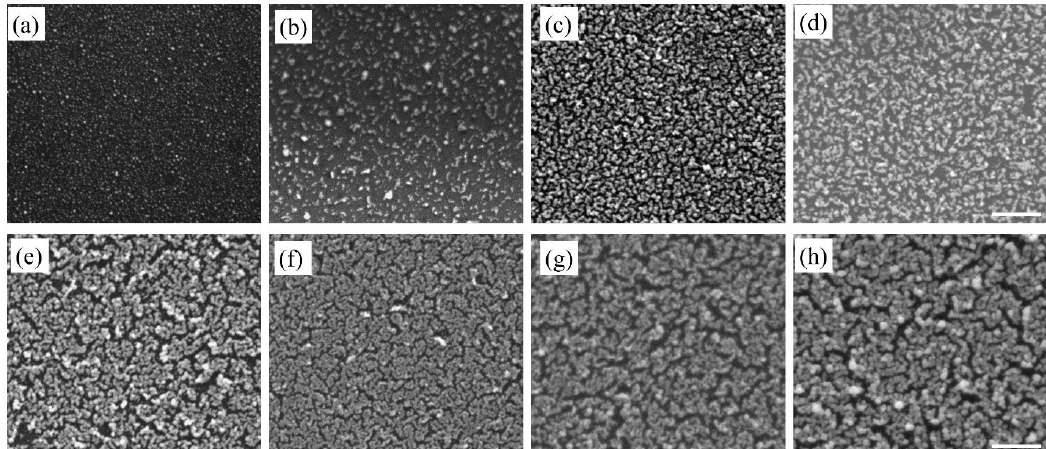
Figure 2. SEM images of Au nanostructures deposited on Si substrate after ( a ) first, ( b ) second, ( c ) third, ( d ) fourth, ( e ) fifth, ( f ) sixth, ( g ) eighth, and ( h ) tenth deposition cycle. The scale bar is 500 nm.